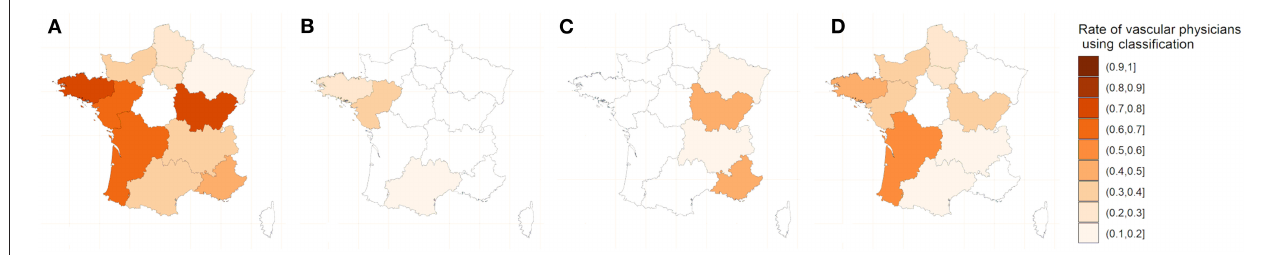
FIGURE 1 | Map of the use of classifications by vascular physicians. (A) One of the three classifications. (B) Saint-Bonnet Classification. (C) Descotes classification. (D) . Spronk classification.